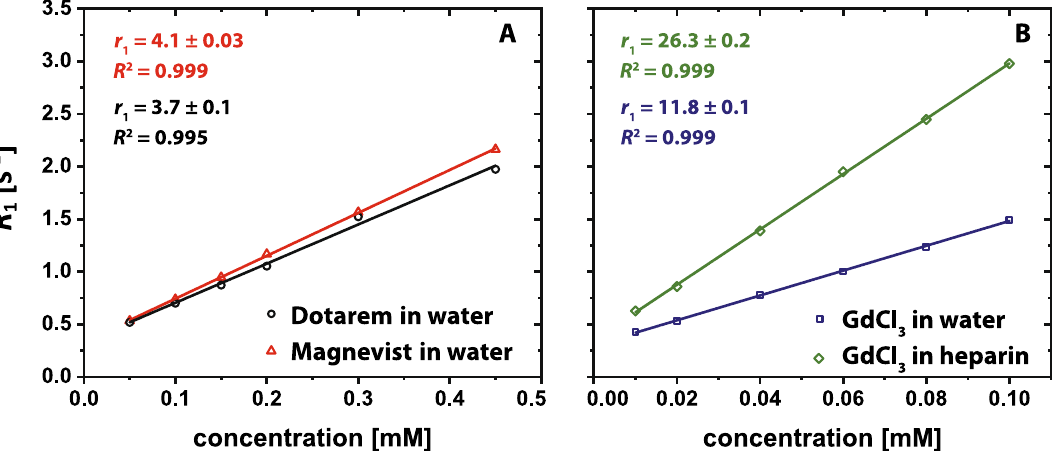
Figure 2. Relaxivity determinations at 9.4 T and 25 °C. ( A ) Relaxivity plots of Magnevist (red triangles) and Dotarem (black circles) in nanopure water. ( B ) Relaxivity plots of GdCl 3 in nanopure water (blue squares) and in aqueous heparin solution (green diamonds; [heparin] = 100 µM). For each data point, the ROI-averaged mean value of ten independently acquired R 1 maps was calculated. The shown relaxivity values are given by the slopes of the obtained linear fits. Please note the different concentration ranges in the